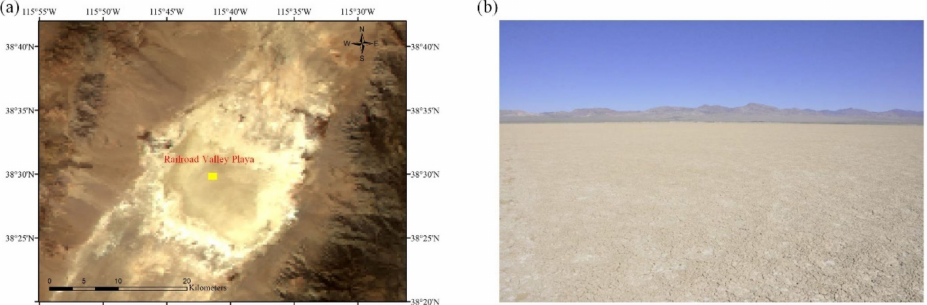
Figure 1. The location and characteristics of Railroad Valley Playa site from ( a ) FengYun-3D MEdium Resolution Spectrum Imager-II (FY-3D MERSI-II)image and ( b ) local snapshot of the dry lakebed from RadCalNet. The yellow block represents the 1 km 2 RadCalNet region.